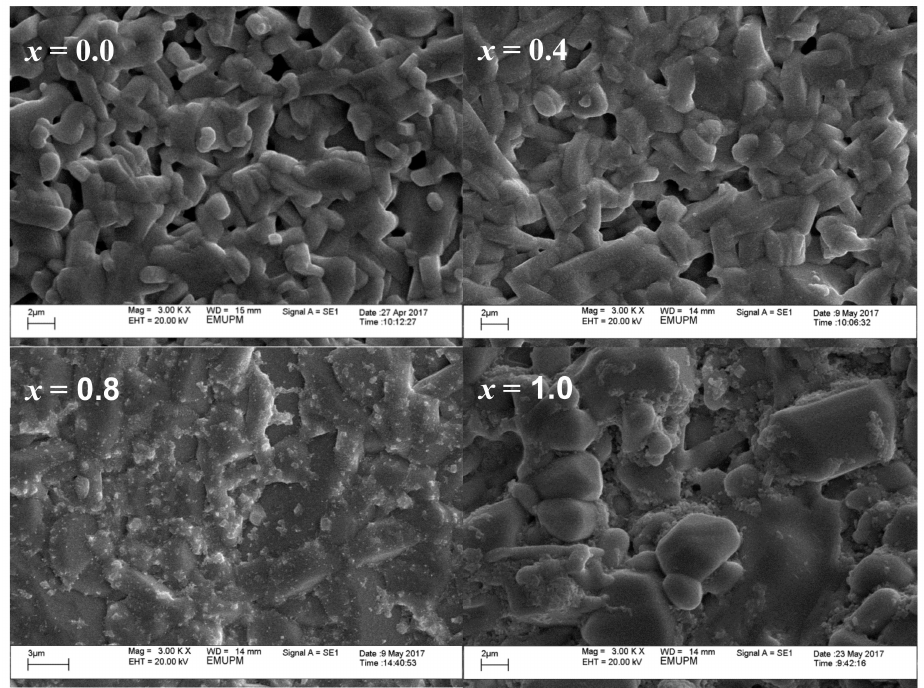
Figure 2. SEM images of Y-123 sample surface at x = 0.0, 0.4, 0.8 and 1.0 wt.% SnO 2